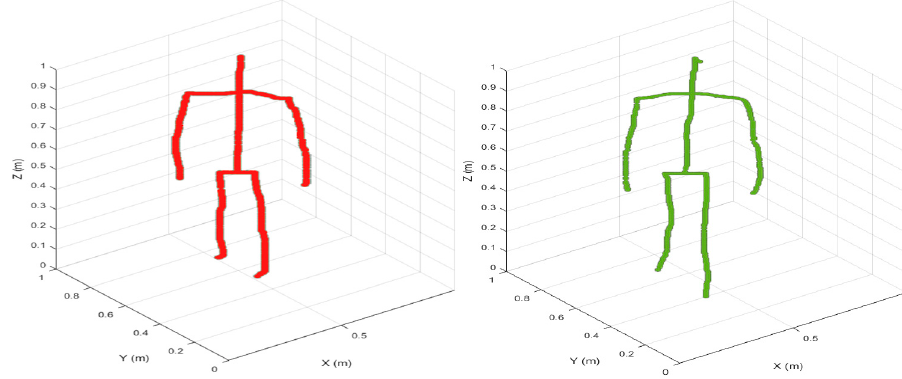
Figure 13. Pose estimation of walking position.